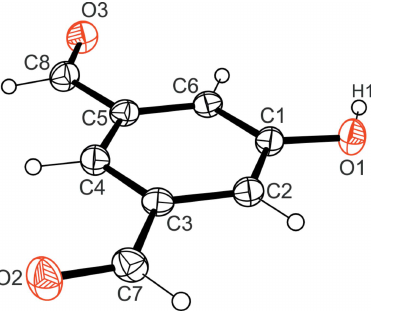
Figure 5 Excerpt of the packing structure of 1 viewed in the direction of the layer normal. Dashed lines represent hydrogen-bonding